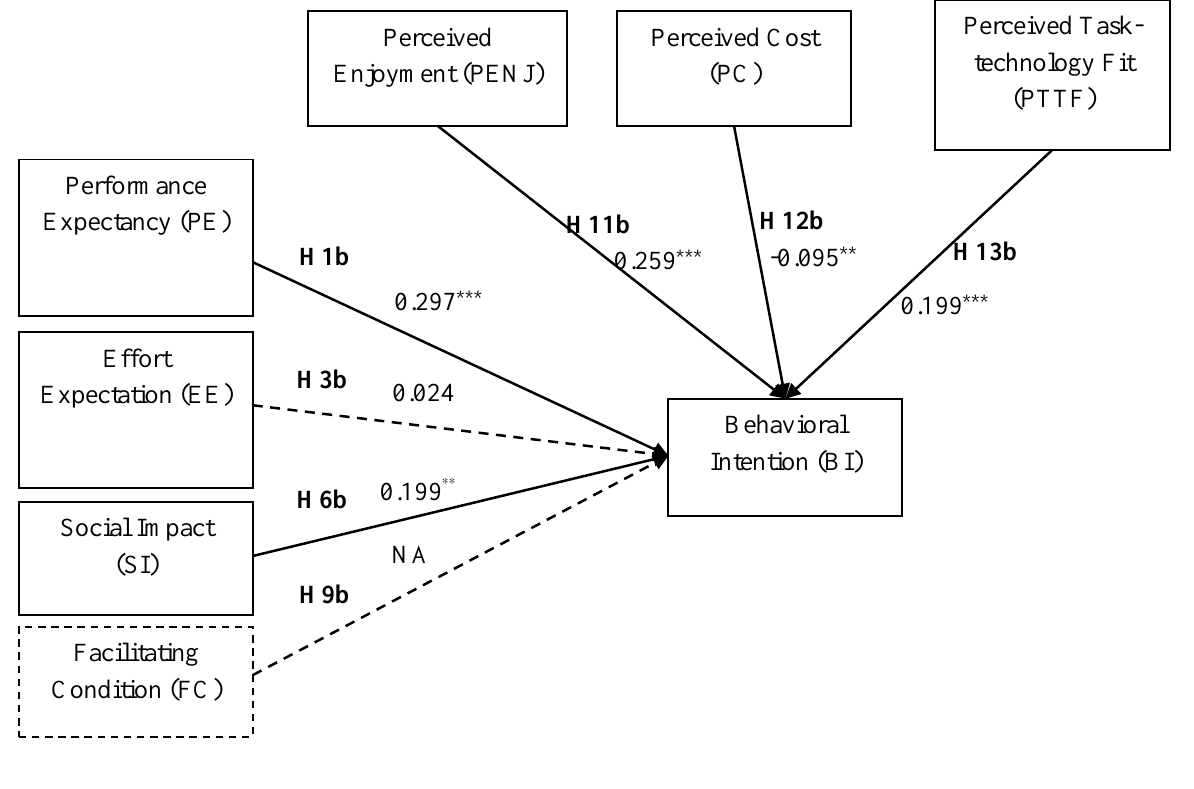
Figure 3. Path analysis of inexperienced